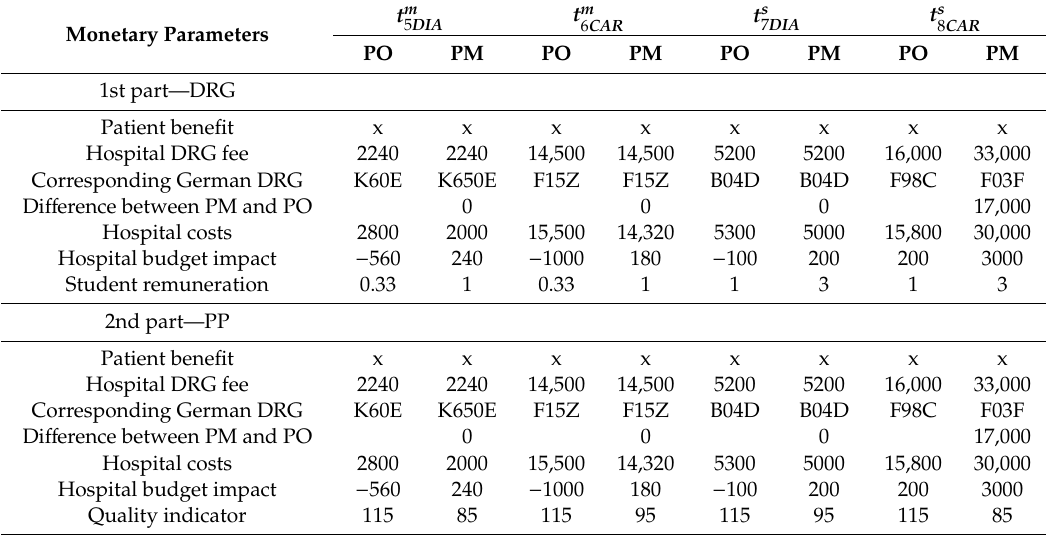
Table A4. Monetary Parameters for Medical Students w / o Patient Benefit—Treatment Cases 5–8. Monetary Parameters